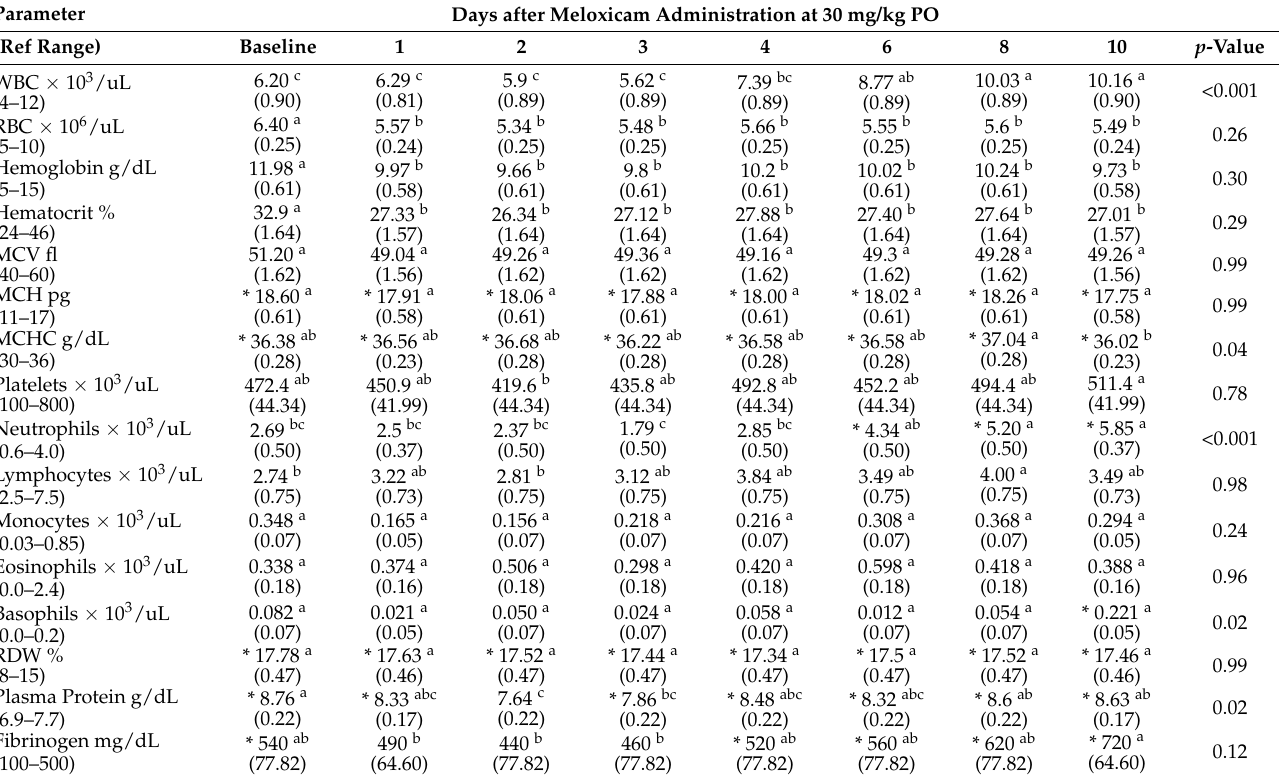
Table 4. Summary of mean ( ± SEM) CBC parameters prior to meloxicam treatment and for 10 days post-treatment for cows administered 30 mg/kg meloxicam per os ( n =